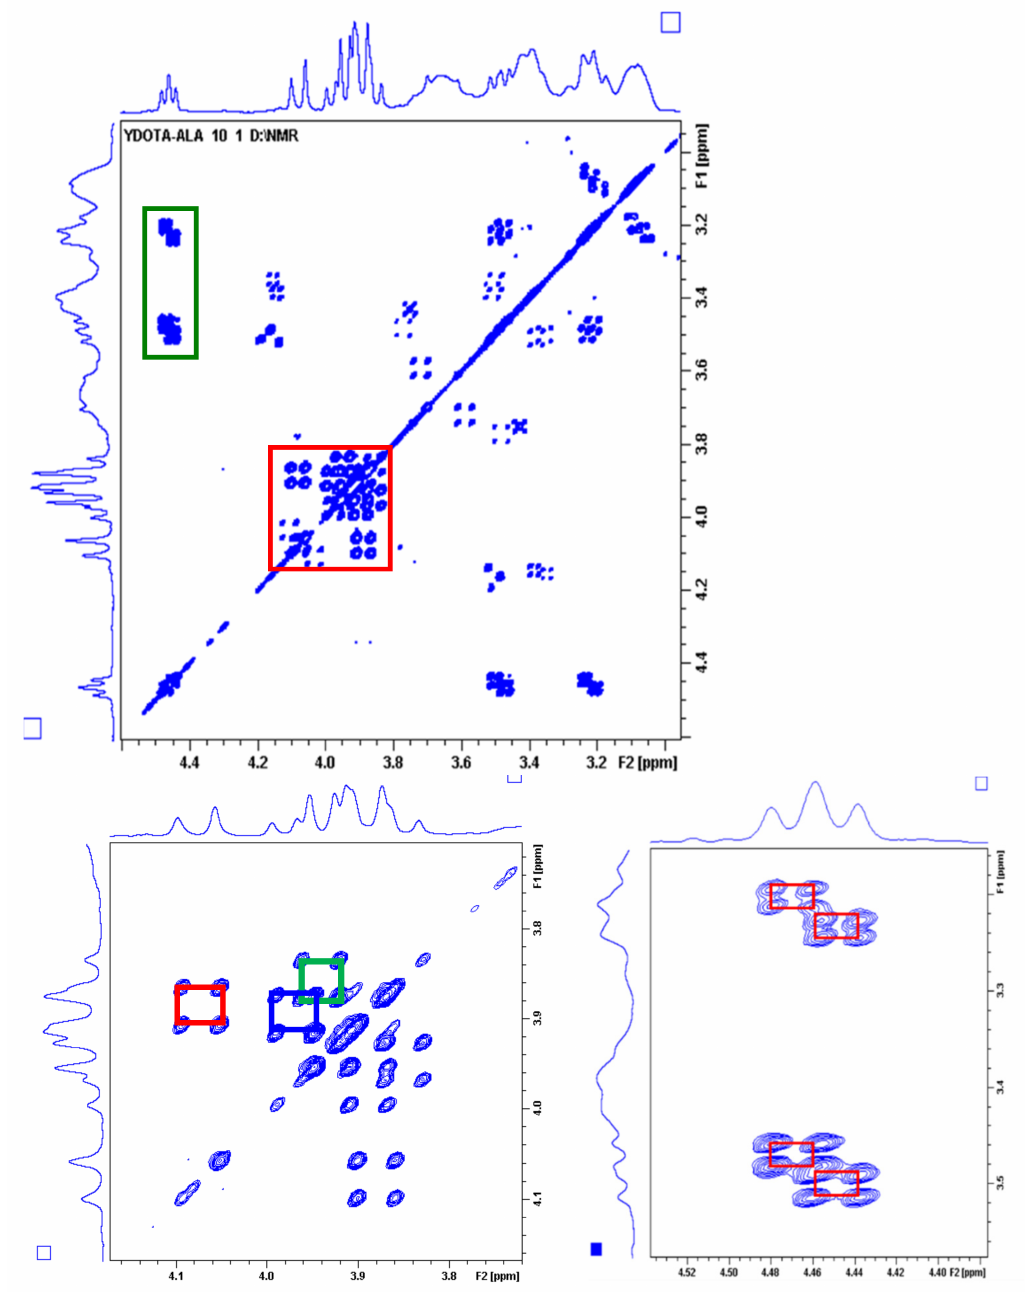
Figure 5. 1 H 2D COSY spectrum of Y(DO3A-ACE) − in D 2 O at 80 ◦ C ( top ) and two expansions ( bottom ): A2, A3, and A4 arm protons are in the left, while the cross peaks between A1s and A1ab protons are in the